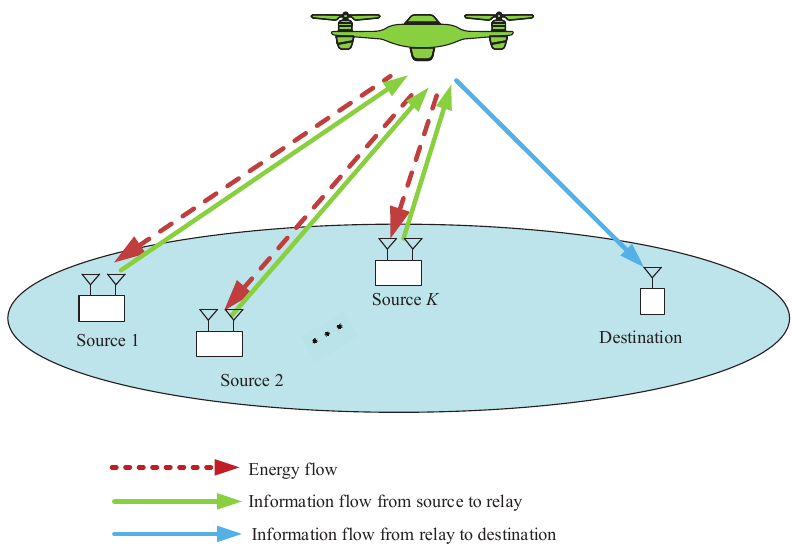
Figure 1. A UAV-enabled